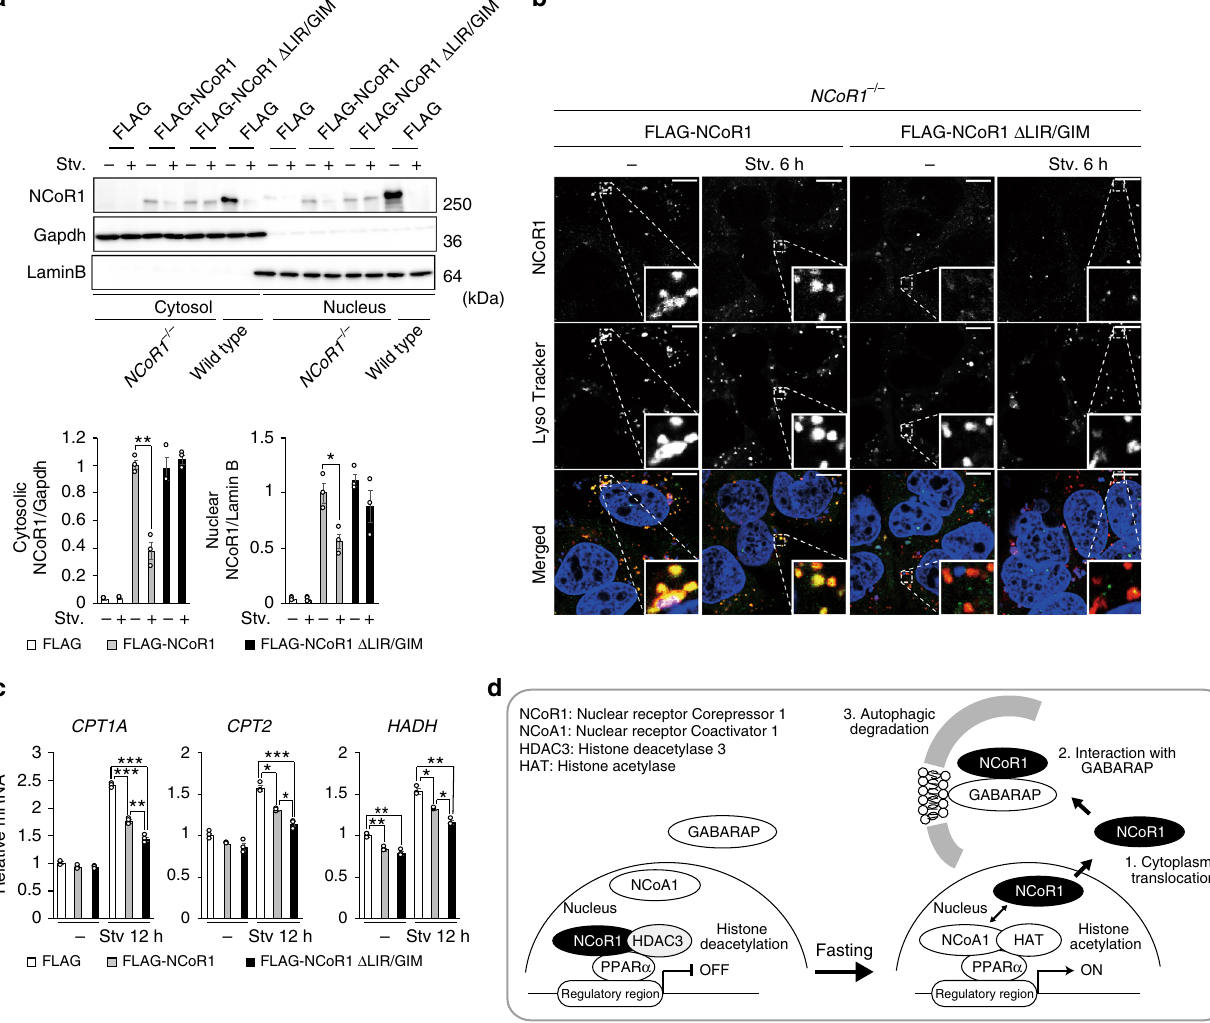
Fig. 9 Autophagic degradation of NCoR1 dependent on the GABARAP-interaction. Immunoblot analysis. FLAG-NCoR1 or NCoR1 Δ LIR/GIM was expressed in NCoR1 -knockout HepG2 cells. Forty-eight hours after transfection, the cells were cultured in nutrient-rich medium, or nutrient-deprived medium. Thereafter, cytoplasmic and nuclear fractions were prepared and subjected to immunoblotting with the indicated antibodies. Data are representative of three independent experiments. Bar graphs indicate the quantitative densitometric analyses of cytoplasmic and nuclear FLAG-NCoR1 and FLAG-NCoR1 Δ LIR/GIM relative to Gapdh and Lamin B, respectively. b Immuno fl uorescence analysis. FLAG-NCoR1 or NCoR1 Δ LIR/GIM was expressed in NCoR1 - de fi cient HepG2 cells. Forty-eight hours after transfection, the cells were cultured in nutrient-rich medium, or nutrient-deprived medium for 6 h and then immunostained with anti-NCoR1 antibody. To label lysosomes, the cells were incubated with Lyso Tracker Deep Red (50 nM fi nal) for 2 h before the immunostaining. c Real-time PCR analysis. Total RNAs were prepared from cells described in a . Values were normalized against the amount of mRNA in NCoR1 -de fi cient HepG2 cells expressing FLAG. The experiments were performed three times. d Model of PPAR α transactivation through selective autophagic degradation of NCoR1. Data are means± s.e.m. * P < 0.05, ** P < 0.01, and *** P < 0.001 as determined by Welch ’ s t